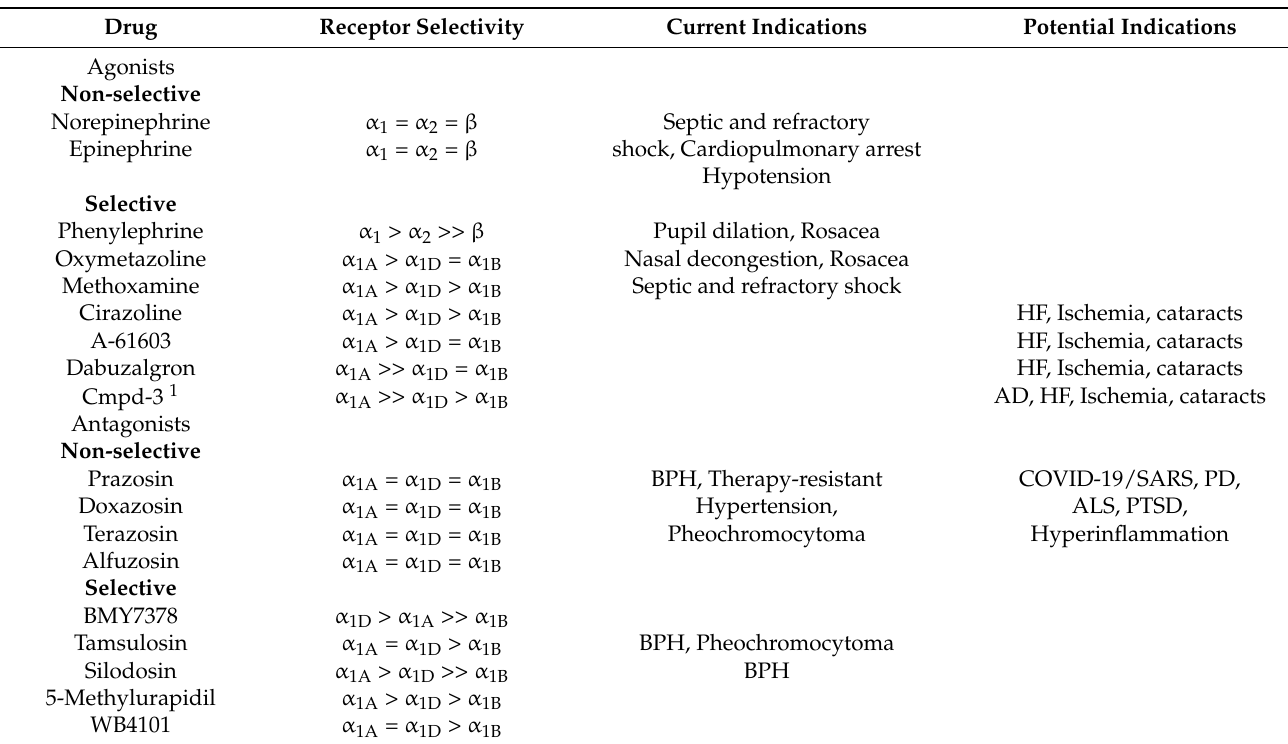
Table 1. α 1 -Adrenergic Receptor Agonists and